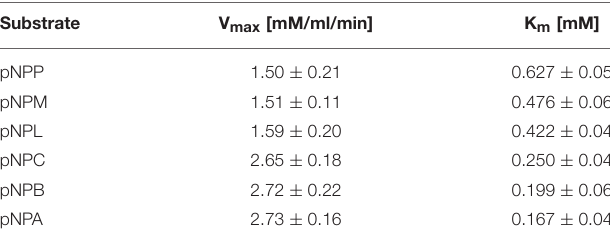
TABLE 2 | Substrate specificity of the